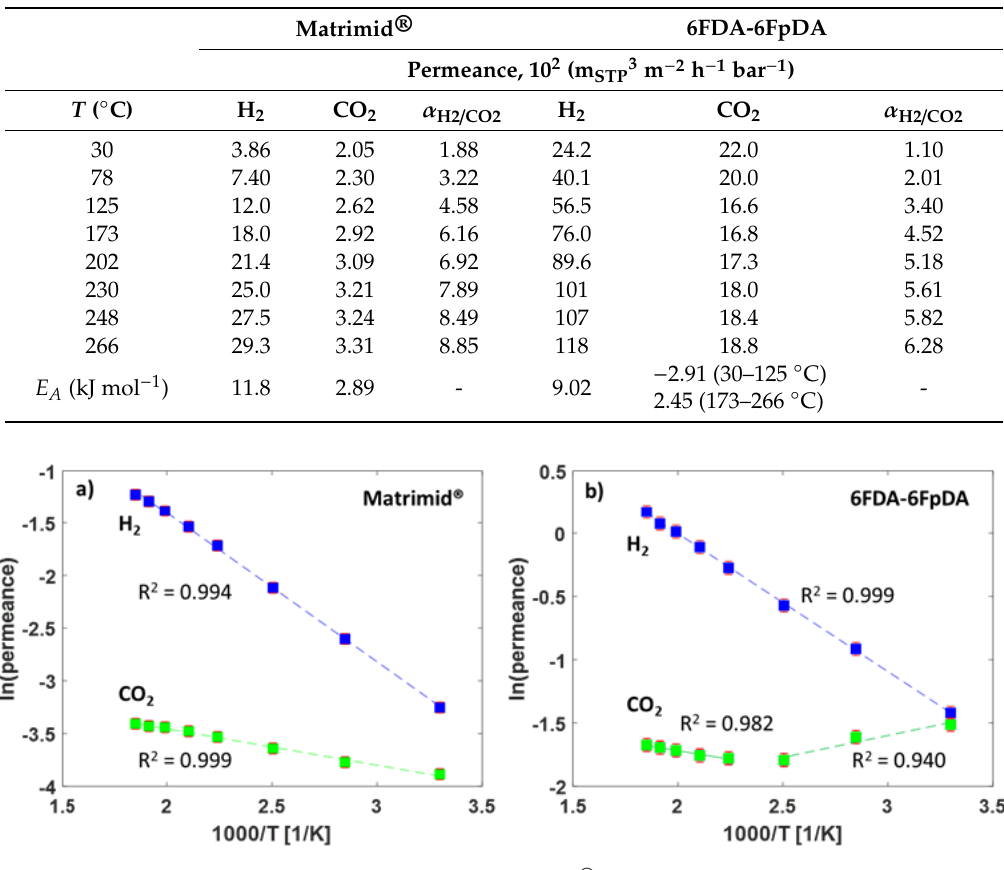
Table 3. Single gas separation properties and activation energies ( E A ) for the thin-film composite membranes in the range of temperatures between 30 and 266 ◦ C for the gas pair CO 2 and H 2 . The E A values were calculated between 30 and 266 ◦ C.